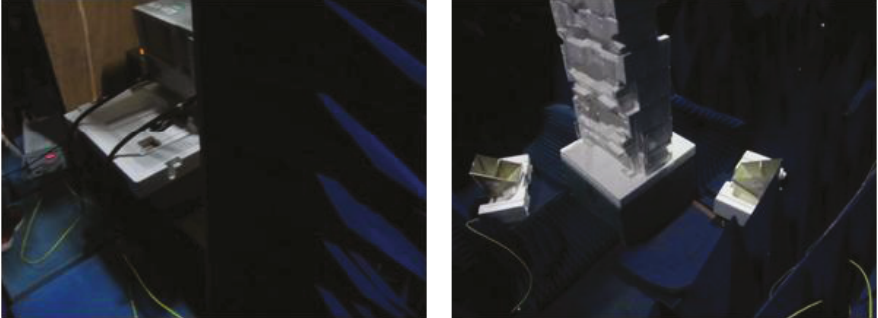
Figure 9: MIMO radar testing